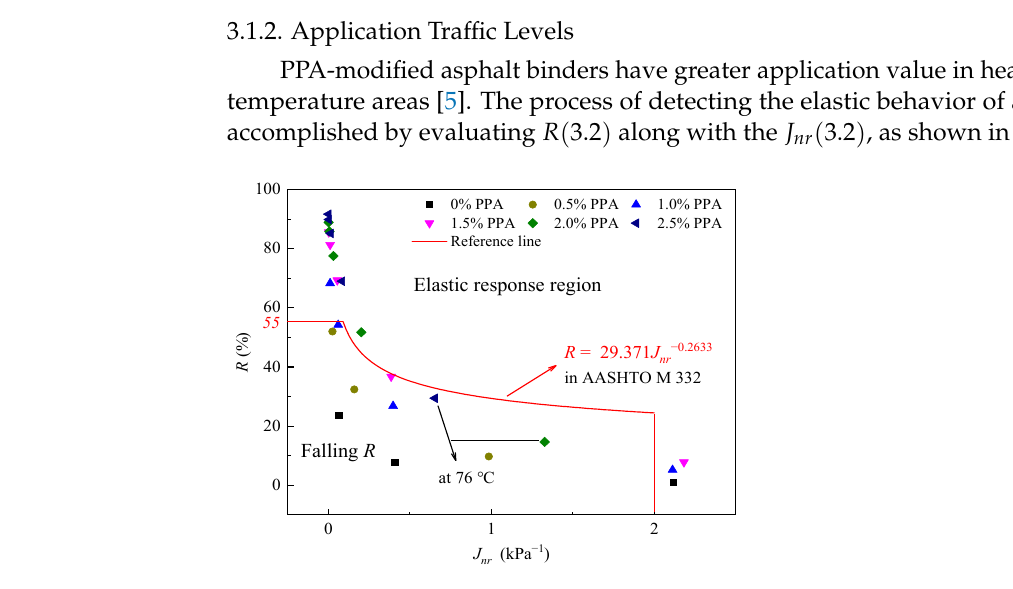
The plotted points on or above the line indicate a more pronounced elastic response of asphalt binders, while the points that fall below the line represent a poor elastic recov-